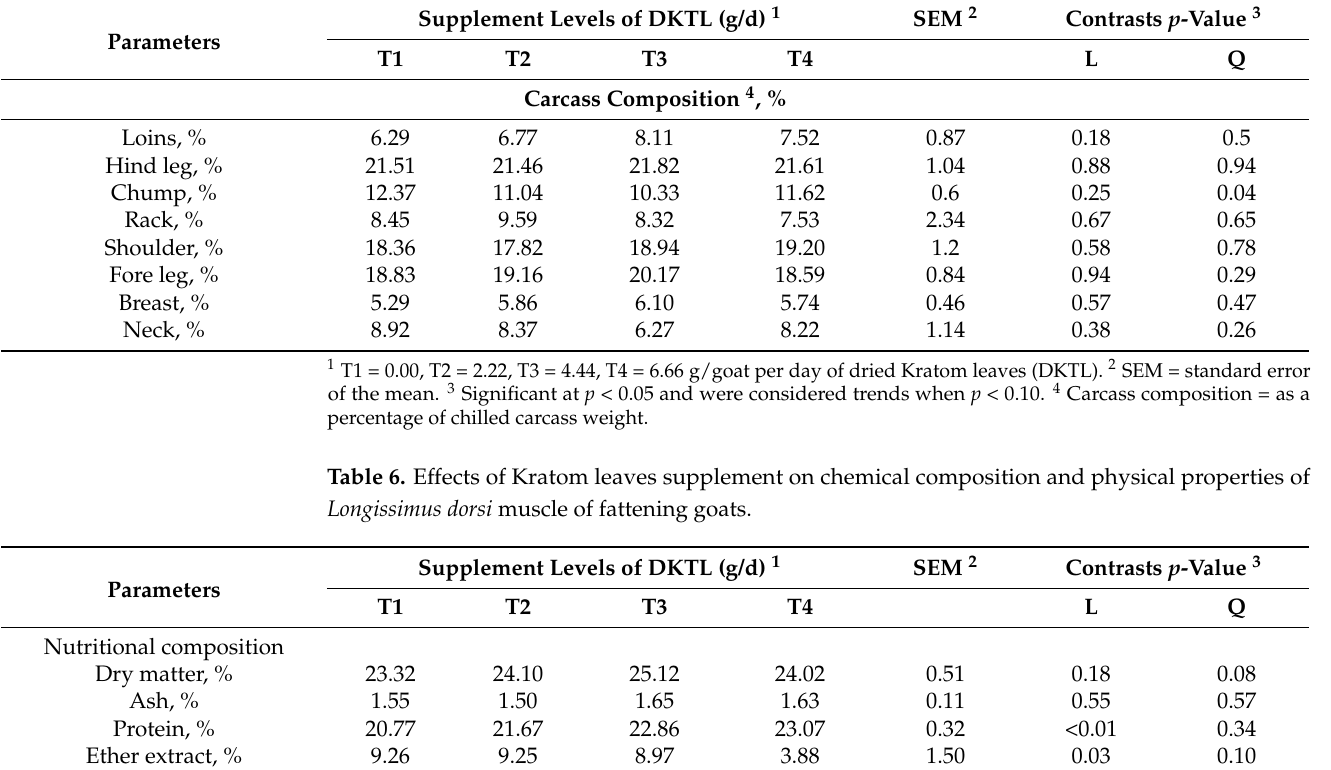
Table 7. With the exception of C12:0, C14:0, C16:1, C18:3n3, and C20:4n6, DKTL